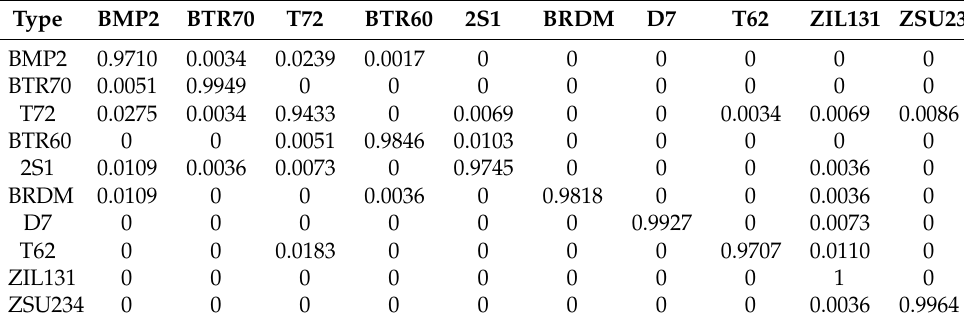
Table 6. Confusion Matrix of the Proposed Method on Ten-Target Data.